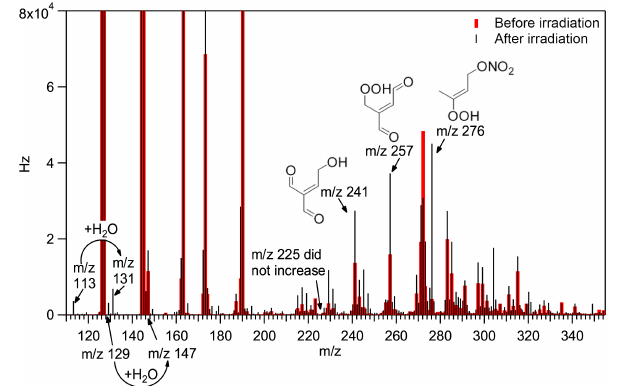
Figure 16. A proposed reaction mechanisms for the nitrooxy enal photolysis reaction. The compounds in boxes are products inferred from nominal masses observed by the CIMS (Fig.